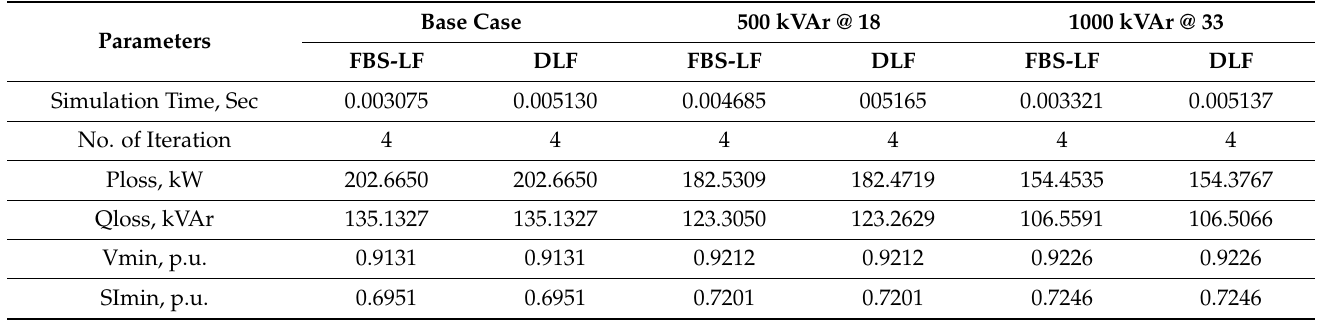
Table 1. Comparison of Performance of Load Flow for incorporation of proposed D-STATCOM Modeling into 33-Bus PDN.